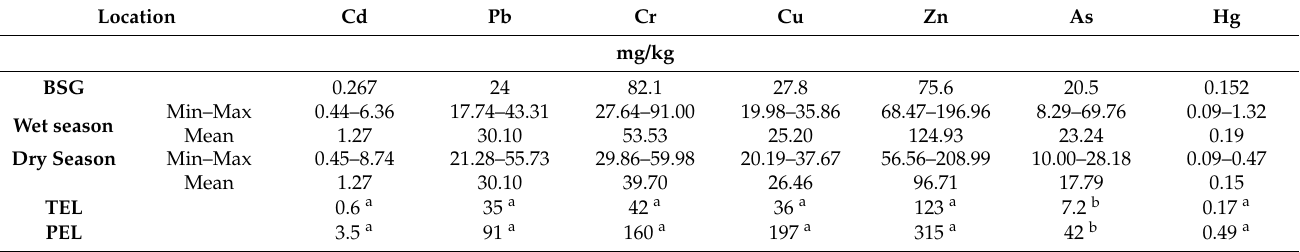
Table 2. Heavy metal concentrations in sediments in Liujiang River Basin. BSG: background values of soil in Guangxi, China; TEL: threshold effect level; PEL: probable effect level.